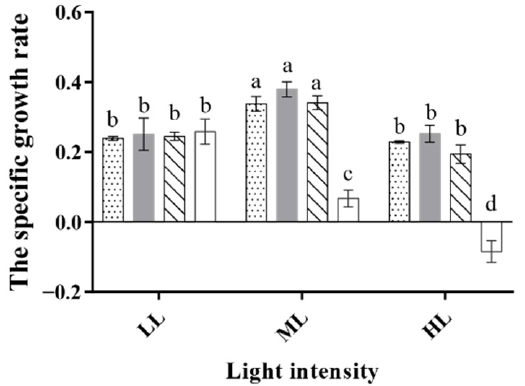
Figure 7. The specific growth rate of H. lacustris under different light conditions with the light/dark cycle methods. Light intensities are 18 μ mol/m 2 ·s (LL), 55 μ mol/m 2 ·s (ML), and 110 μ mol/m 2 ·s (HL). Continuous light (white bar), 2/2 s (dot bar), 2/2 h (gray bar), and 6/6 h (striped bar). Different superscript letters indicate significant differences among treatments (two-way ANOVA with Tukey correction, p < 0.05).